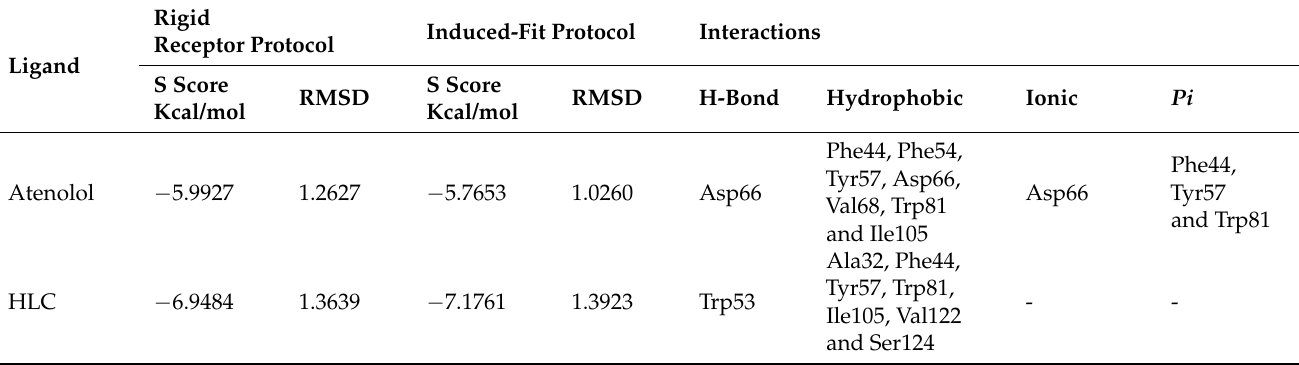
Table 3. Docking results for both HLC and atenolol with S. marcescens SmaR.